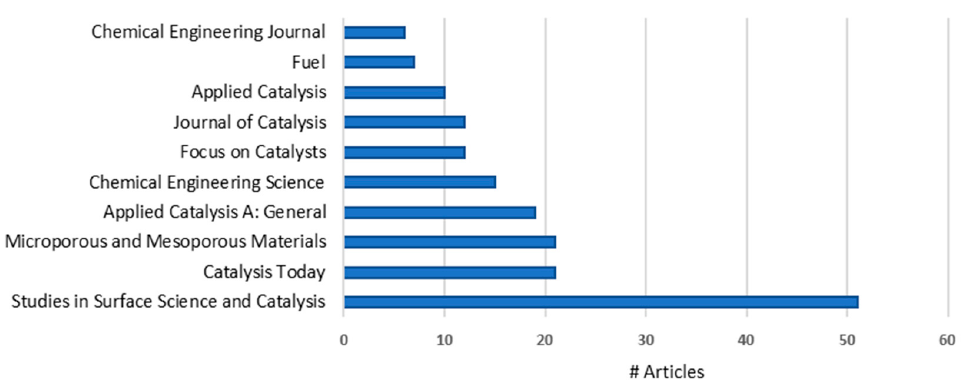
Figure 3. Articles retrieved with the Refining Terms distributed in 5-year clusters .